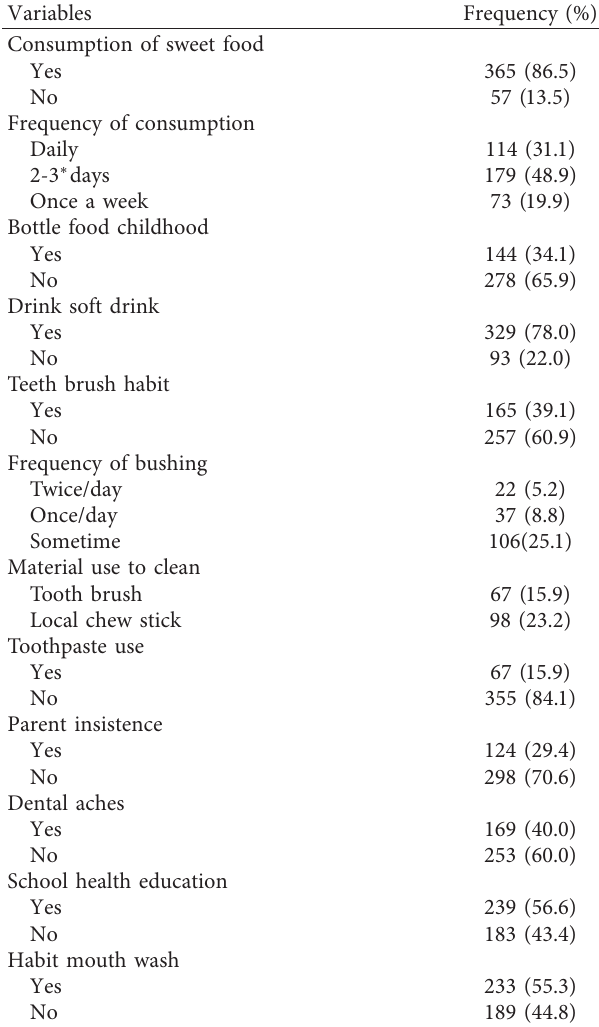
Table 2: Sociodemographic characteristics of primary school children in Alem Ketema, North Shewa, Ethiopia, 2020 ( n � 422).